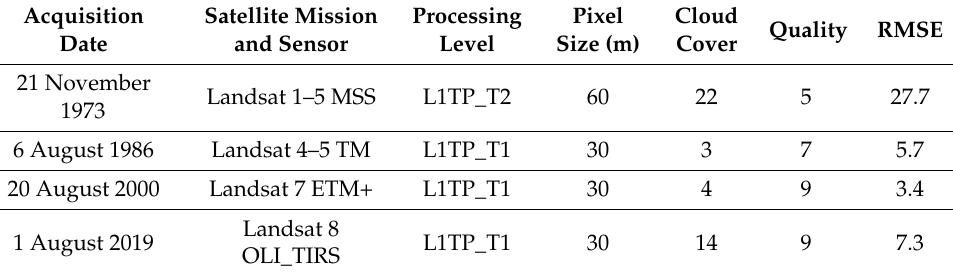
Table 1. Technical details of the satellite images for the Hola Basin, Northeast